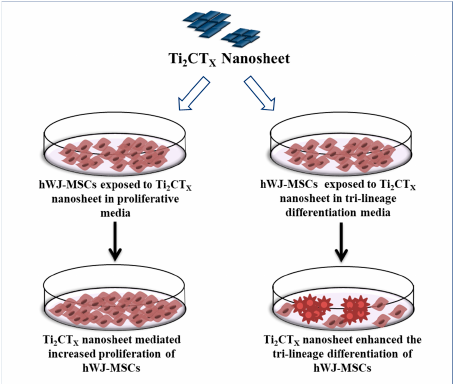
Figure 1. Schematic representation of research study. 2.1. Characterization of Ti 2 CTx MXene The Ti 2 CTx nanosheets were synthesized by selectively etching the aluminum layer